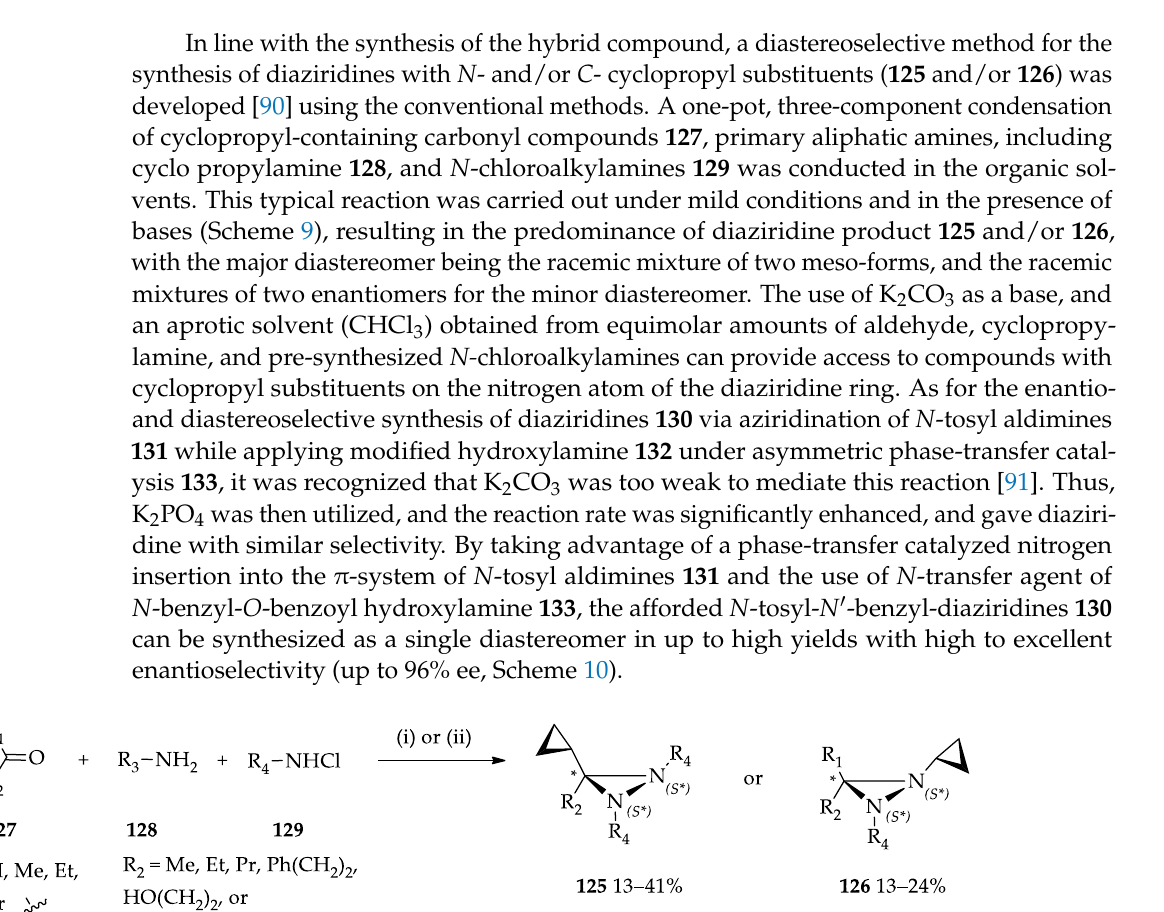
Figure 16. Synthesis of monodiaziridine 123 and bidiaziridine 121 from α -diimines 122 ( A ) and further substitution for 123 ( B ). Conditions: (i) NsONHCO 2 Et, H 2 O/CH 2 Cl 2 , CaO, rt; (ii) m -CPBA, CH 2 Cl 2 , 0 °C.